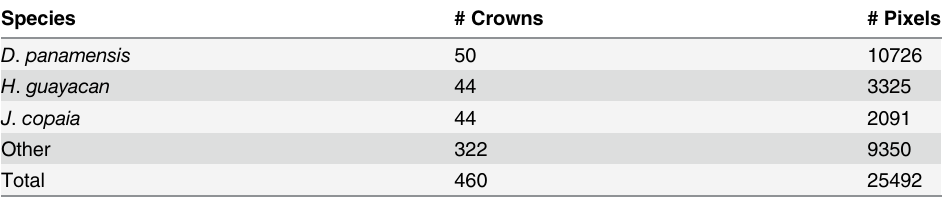
Table 1. Summary of the spectral data from both the field-collection campaign and the crowns obtained from satellite data. Species # Crowns #